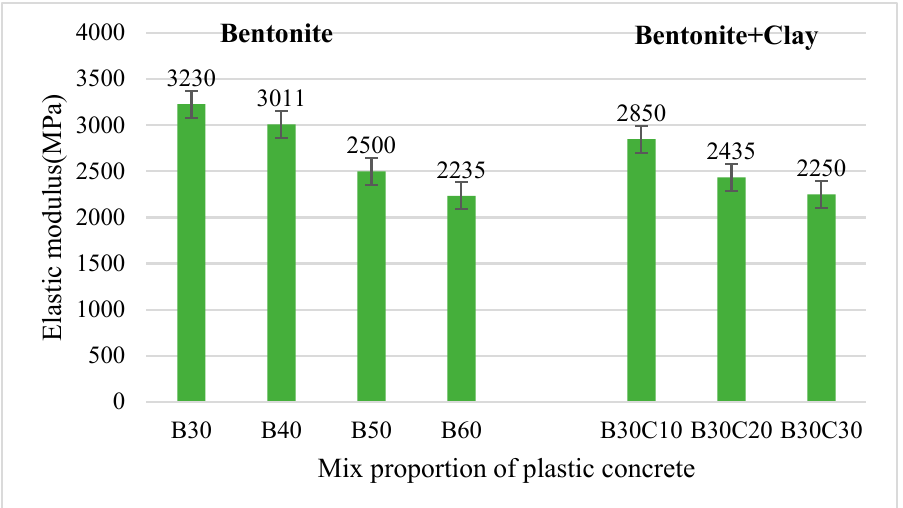
Figure 3. Elastic modulus of plastic concrete mixed with bentonite and clay.